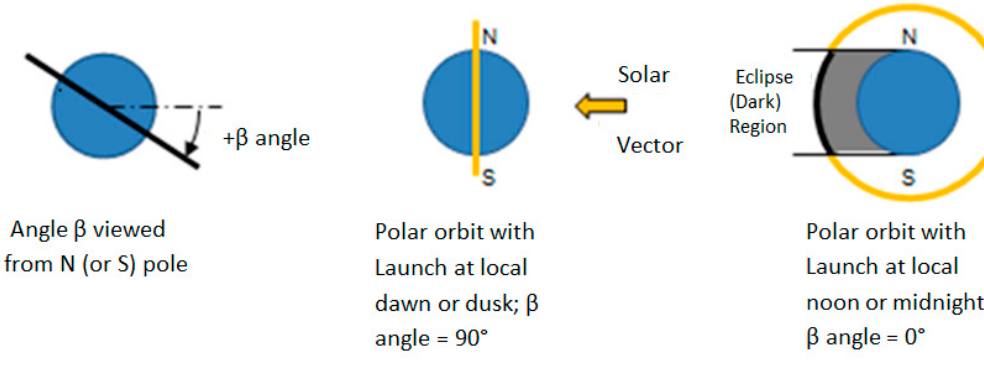
Figure 46. Polar Orbit Launch Configurations [20].